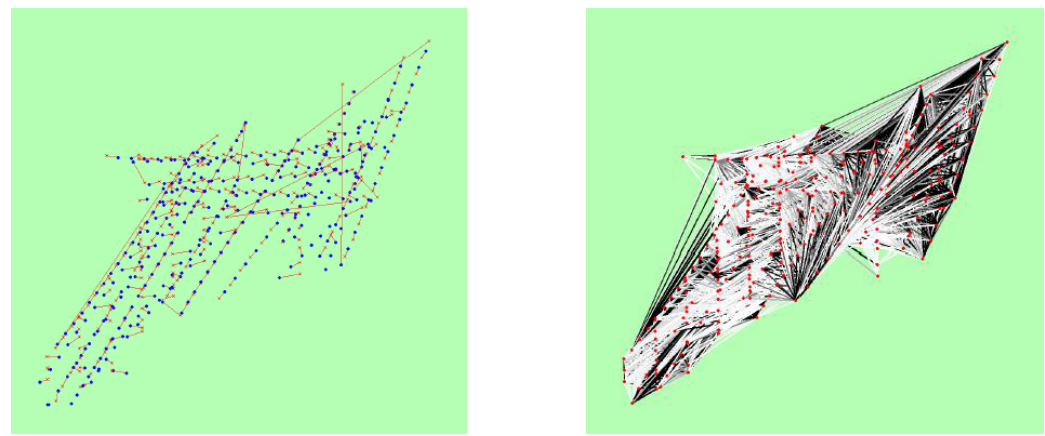
Figure 3: Computed camera centers for the combined processing of visible and NIR images for the example in Figure 1 (left Figure). The reprocessed camera centers (blue dots) are connected to the corresponding GPS measurements by red lines. The Figure on the right shows the number of matches between all images color coded (black is indicating many matches between image pairs).